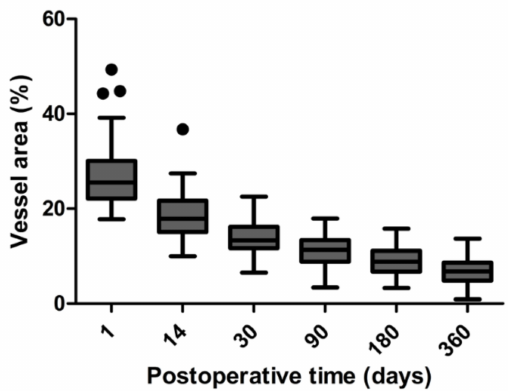
Figure 2. Box plot presentation of time-dependent changes of vascularity of the filtering blebs at all follow-up visits in the study. The change rate of the blood vessel area significantly decreased. Median values (horizontal lines), 25 / 75 percentiles (boxes), 5 / 95 percentiles (whiskers) and outliers